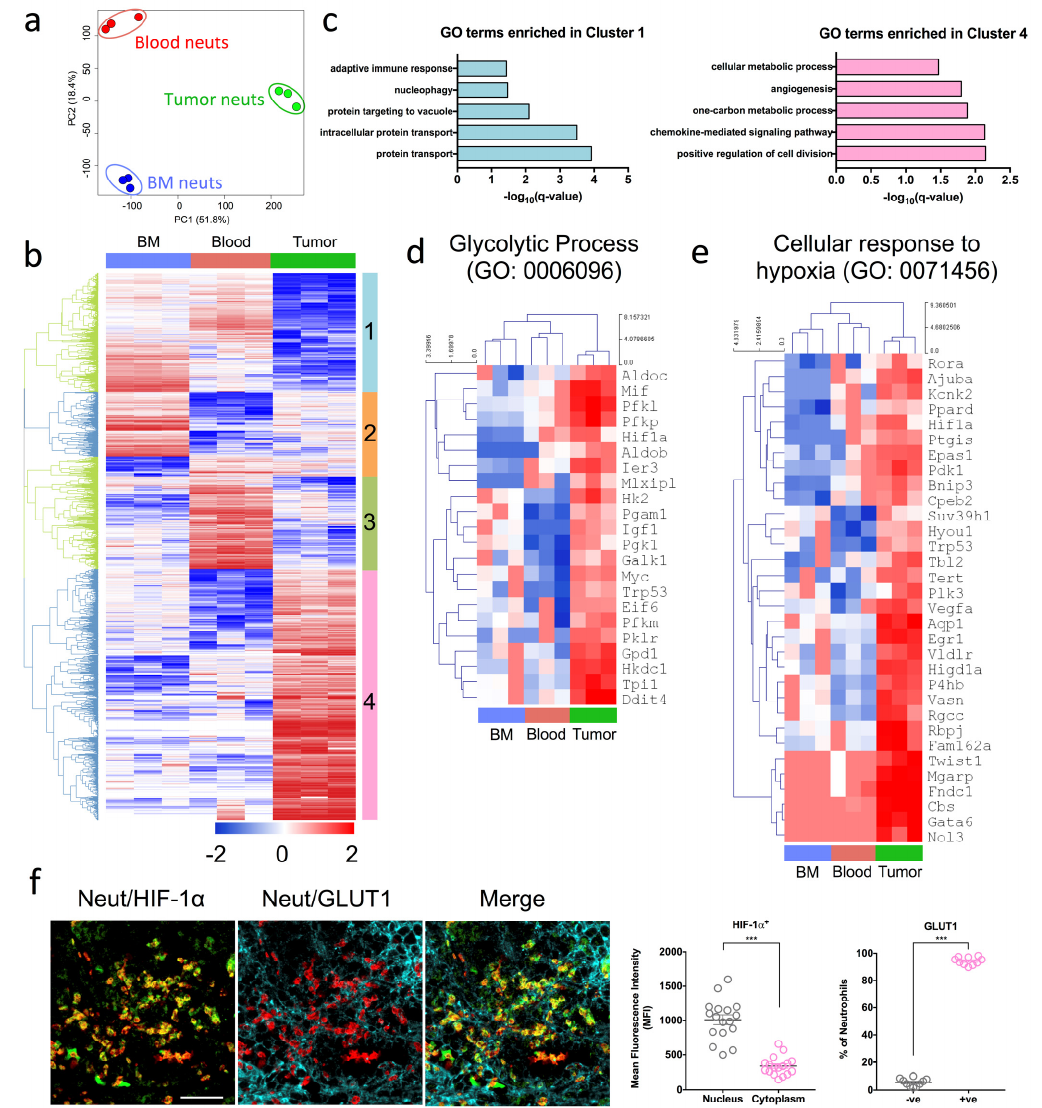
Figure 2. Pro-tumoral neutrophils exhibit a highly glycolytic signature and are adapted to a hypoxic tumor microenvironment ( a – e ) Bone marrow (BM), blood and tumor neutrophils were sorted based on their expression of Dapi-CD45 + Lin(CD3/B220/NK1.1) − Ly6G + Ly6C+ (orthotopic transplanted [OT] n = 5 mice pooled, three independent experiments). Hierarchical clustering and principal component analysis (PCA) were performed with log2–transformed values. ( a ) PCA plots of tran- scriptomic data of BM, blood and tumor neutrophils respectively. ( b ) Heat map of the differentially expressed genes selected with Benjamini–Hochberg adjusted p -values < 0.05. Four gene clusters (1 to 4) were manually defined and exported for gene ontology (GO) biological process analysis. ( c ) GO biological process terms enriched in clusters 1 ( left ) and 4 ( right ). ( d , e ) Expression of genes with row/gene-based z-score values (log2 FPKM) of cluster 4-associated genes across all sorted populations encoding ( d ) GO: 0006096—Glycolytic process and ( e ) GO: 0071456—Cellular response to hypoxia. ( f ) Representative immunofluorescence staining of pancreas sections from OT mice stained with Dapi (blue), S100A9 (red) neutrophil marker, and HIF-1 α (green) and GLUT1 (cyan) glycolytic markers. Immunofluorescence images shown are representative images of n = 3 mice, and 10–15 fields of view. Scale bar = 100 µ M. Scatter plots represent the mean fluorescence intensity (MFI) of HIF-1 α + neutrophils staining in the nucleus and cytoplasm, and percentage of GLUT1 expressing neutrophils in the tumor. Data represent the means ± SEM, *** p < 0.001 by unpaired Student’s t -test with a 95% confidence